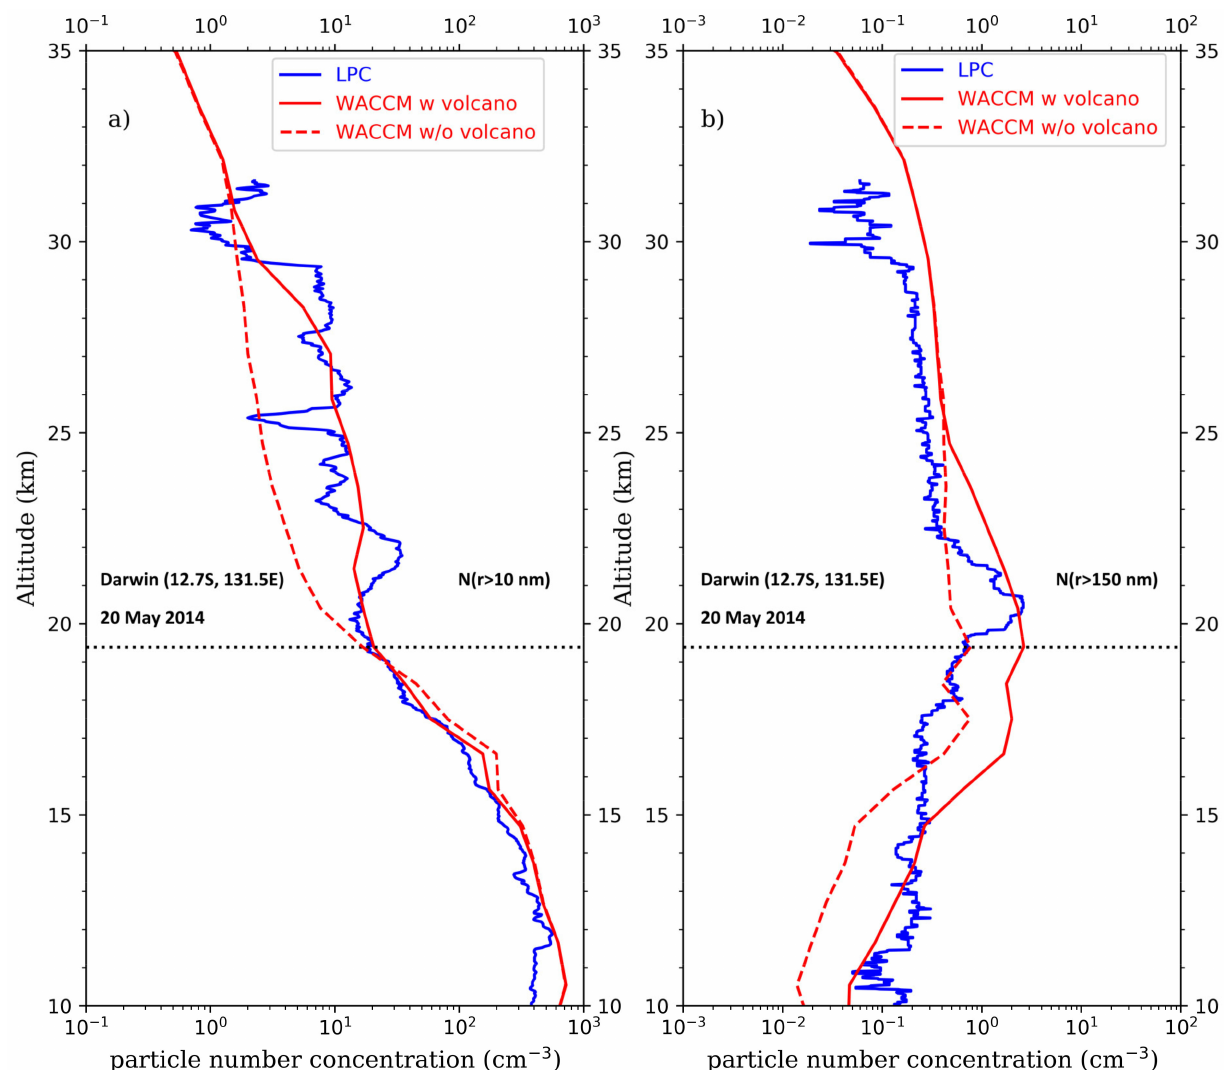
Figure 6. Profiles of particle number concentrations measured by the LPC from a balloon flight near Darwin on 20 May 2014 (blue) and simulated by the WACCM-CARMA model at the closest grid point of the in situ observations (red). Concentrations are shown for particles with radii r > 10 nm ( a ) and r > 150 nm ( b ). The model profiles are shown for the volcano-on (red full lines) and the volcano-off simulations (red dashed lines). Measurement error bars have not been included for clarity of the figures. The position of the tropopause is shown by the horizontal dotted